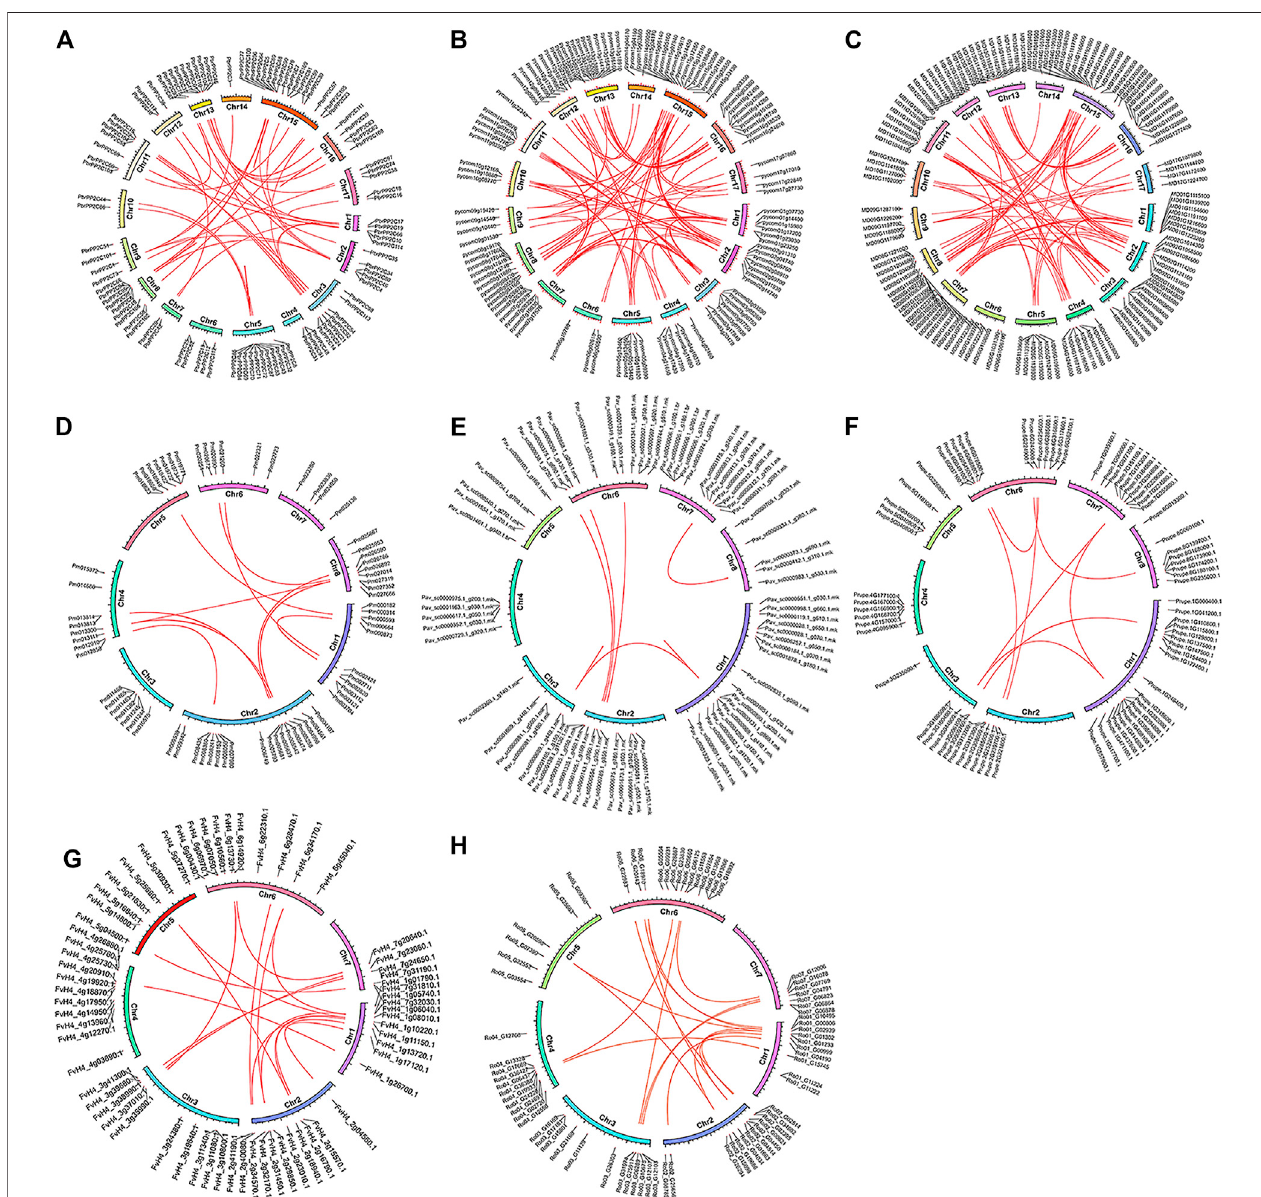
FIGURE3| Genelocation and collinearity analysisof the PP2C gene family. (A) Chinese whitepear; (B) European pear; (C) apple; (D) Japanese apricot; (E) sweet cherry; (F) peach; (G) strawberry; (H) black raspberry. Genes were located on different chromosomes. Red lines represent the syntenic gene pairs.